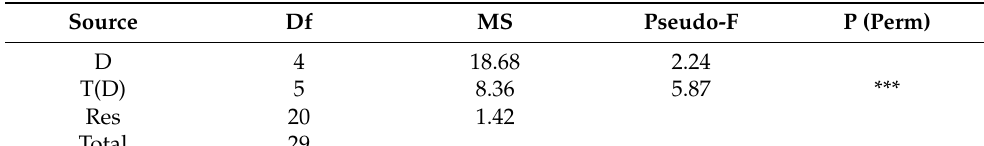
Table 1. Results of multivariate permutational analyses (PERMANOVA) on seston and zooplank- ton composition across several temporal scales (Day, Time).